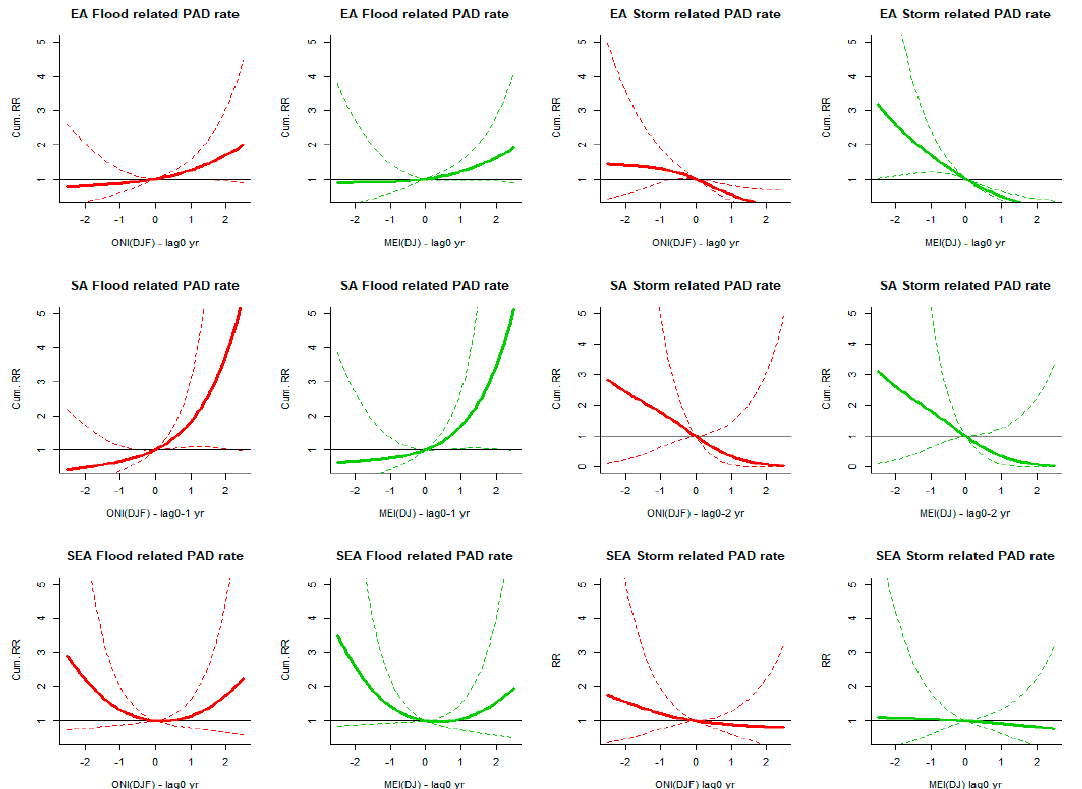
Figure A2. Relationships between ONI or MEI and flood- and storm-related PADs, by region of Asia (EA: Eastern Asia, SA: Southern Asia, SEA: Southeast Asia), 1964–2017. Solid lines represent the estimated relationship and dashed lines are 95% confidence limits.